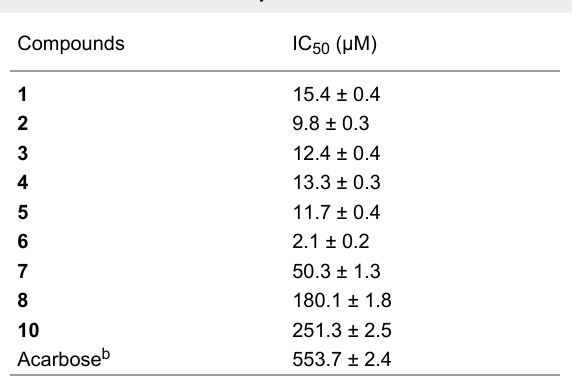
Table 3: α -Glucosidase inhibitory activities a